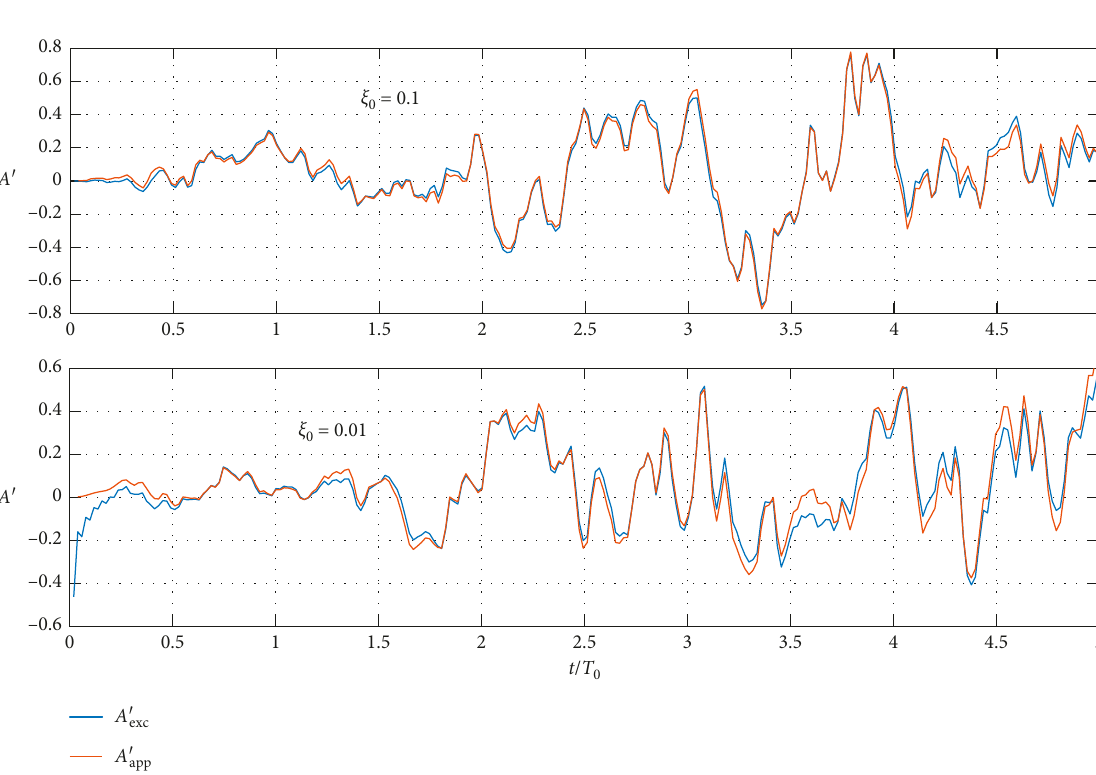
Figure 5: Approximate and exact nonstationary solutions for T